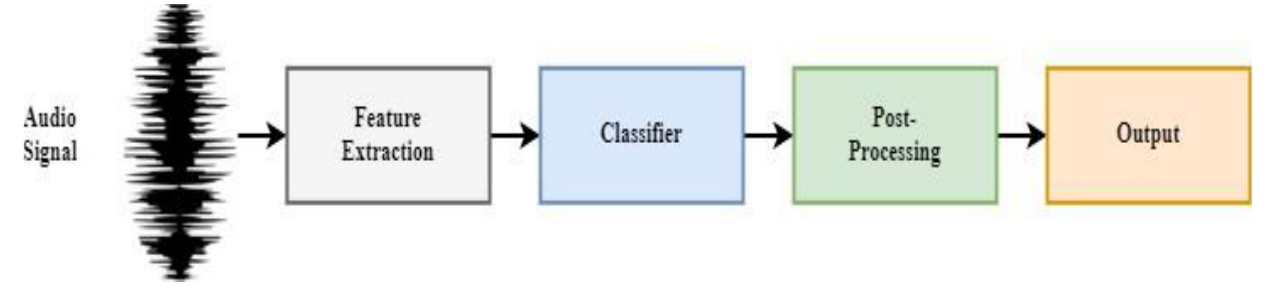
Figure 2. Proposed stacked multi-model for SED.